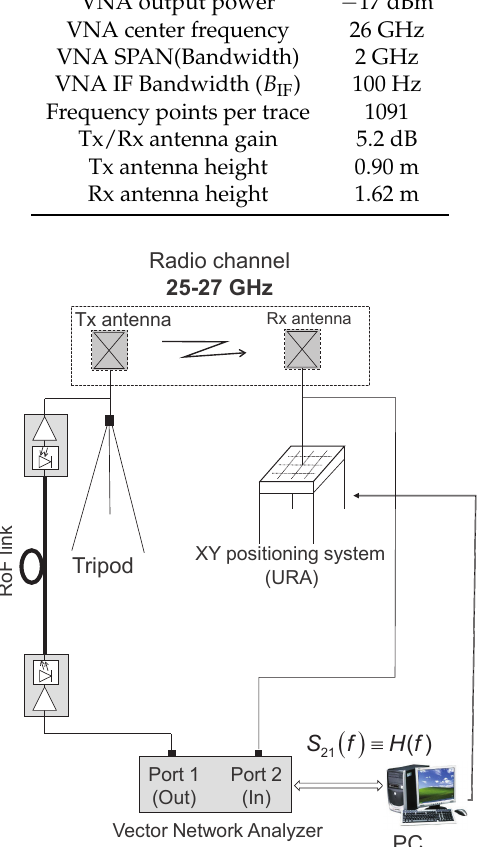
Figure 3. Schematic diagram of the channel